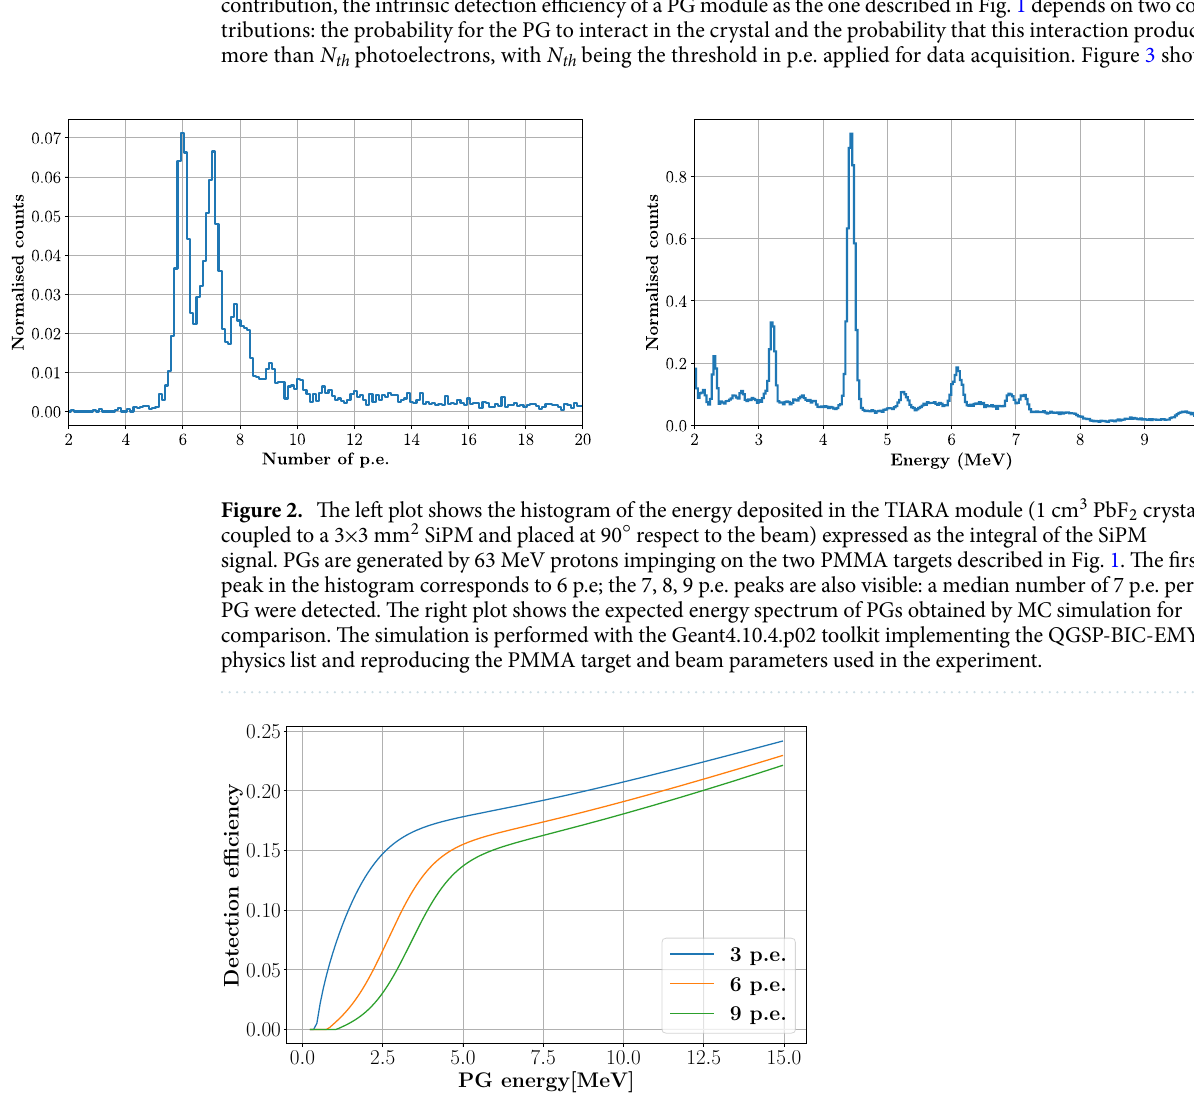
Figure 3. Intrinsic detection efficiency (neglecting geometrical efficiency) of a PG detection module composed of a 1 cm 3 PbF 2 crystal coupled to a 3 3 mm 2 SiPM. The three functions were obtained from MC simulation × using the Geant4.10.4.p02 toolkit with the QGSP-BIC-EMY physics list to establish the PG interaction probability, while the UNIFIED model was applied to model the interactions of Cherenkov photons inside the crystal. Three different thresholds of 3, 6 and 9 p.e. were